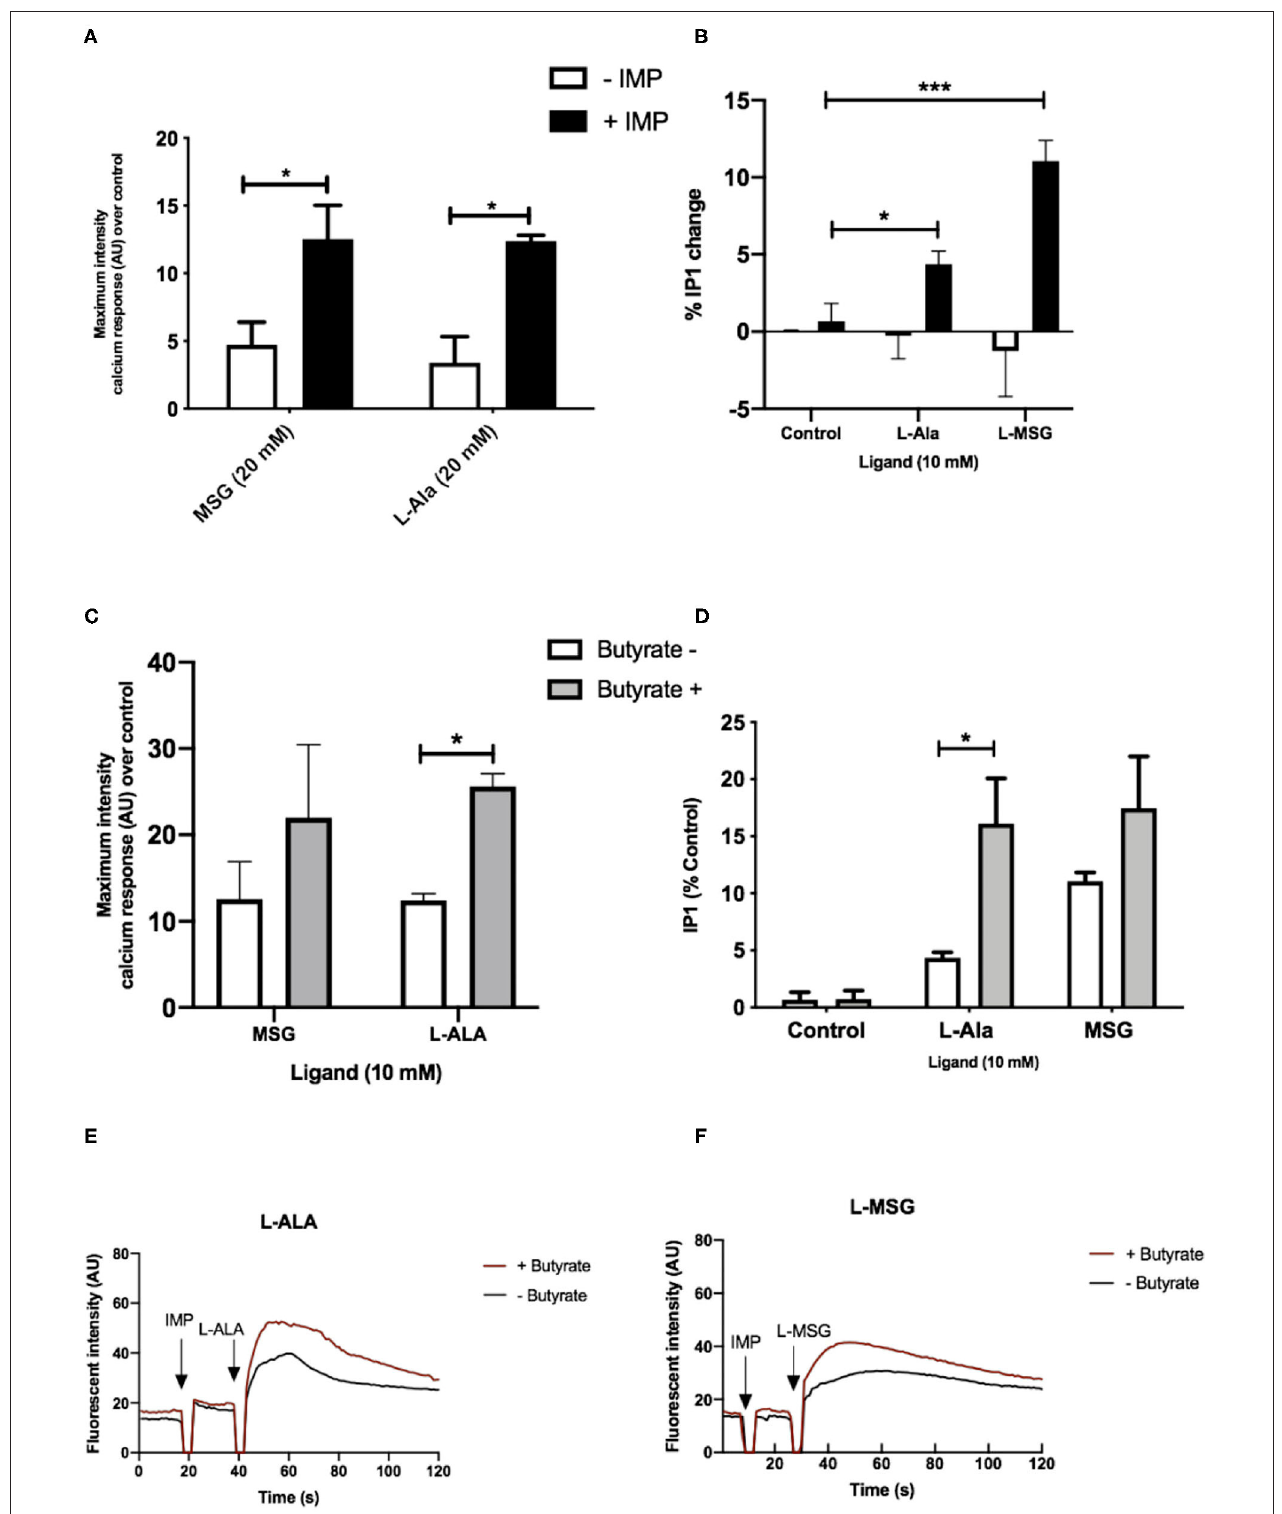
FIGURE 4 | Umami receptor signaling cascades are potentiated by butyrate pretreatment. (A) Intracellular Ca 2 + levels measured in STC-1 cells, incubated with fluorescence Ca 2 + indicator dye Fluo4-AM following addition of IMP (2mM, black bars) or NaCl control (white bars; 2mM) with L-Ala (20mM) or L-MSG